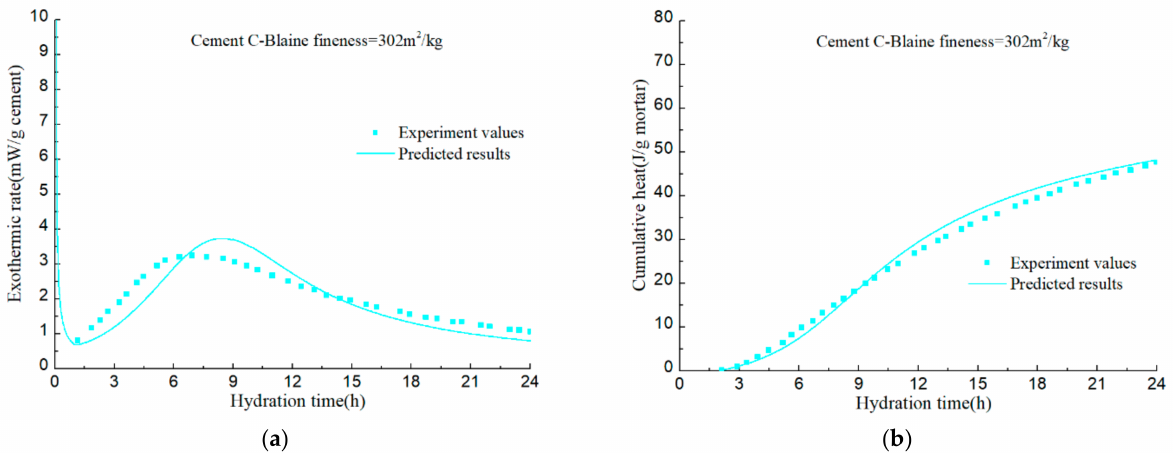
Figure 24. Isothermal calorimetry test values and model prediction results of Cement III: ( a ) hydration heat release rate per unit mass of cement; ( b ) cumulative hydration heat of per unit mass of